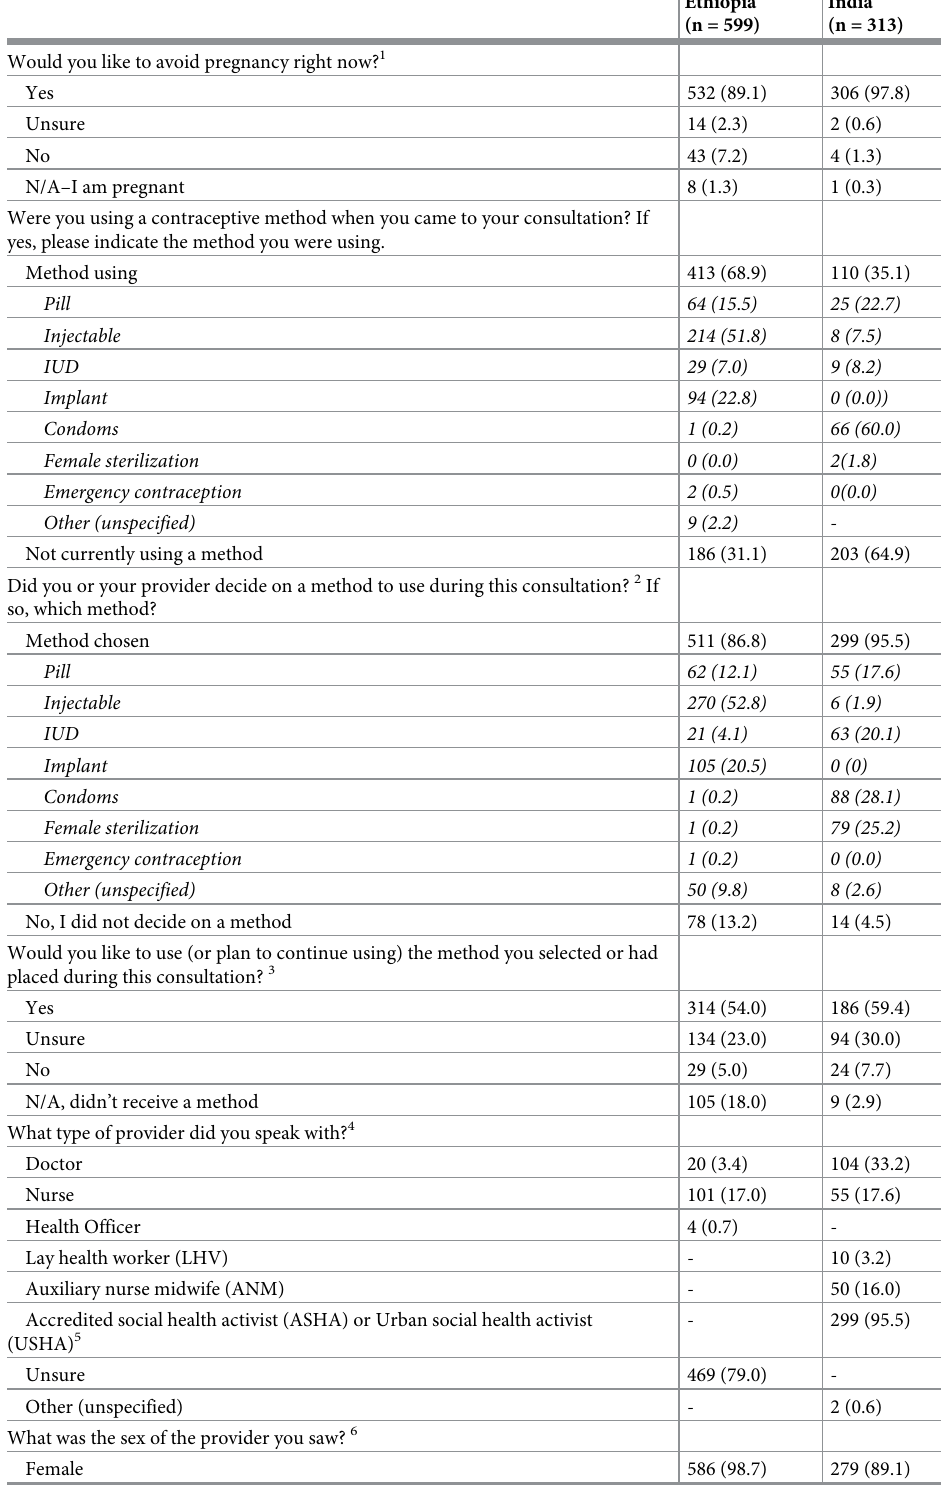
Table 2. Participant contraceptive choices and preferences and visit characteristics, n